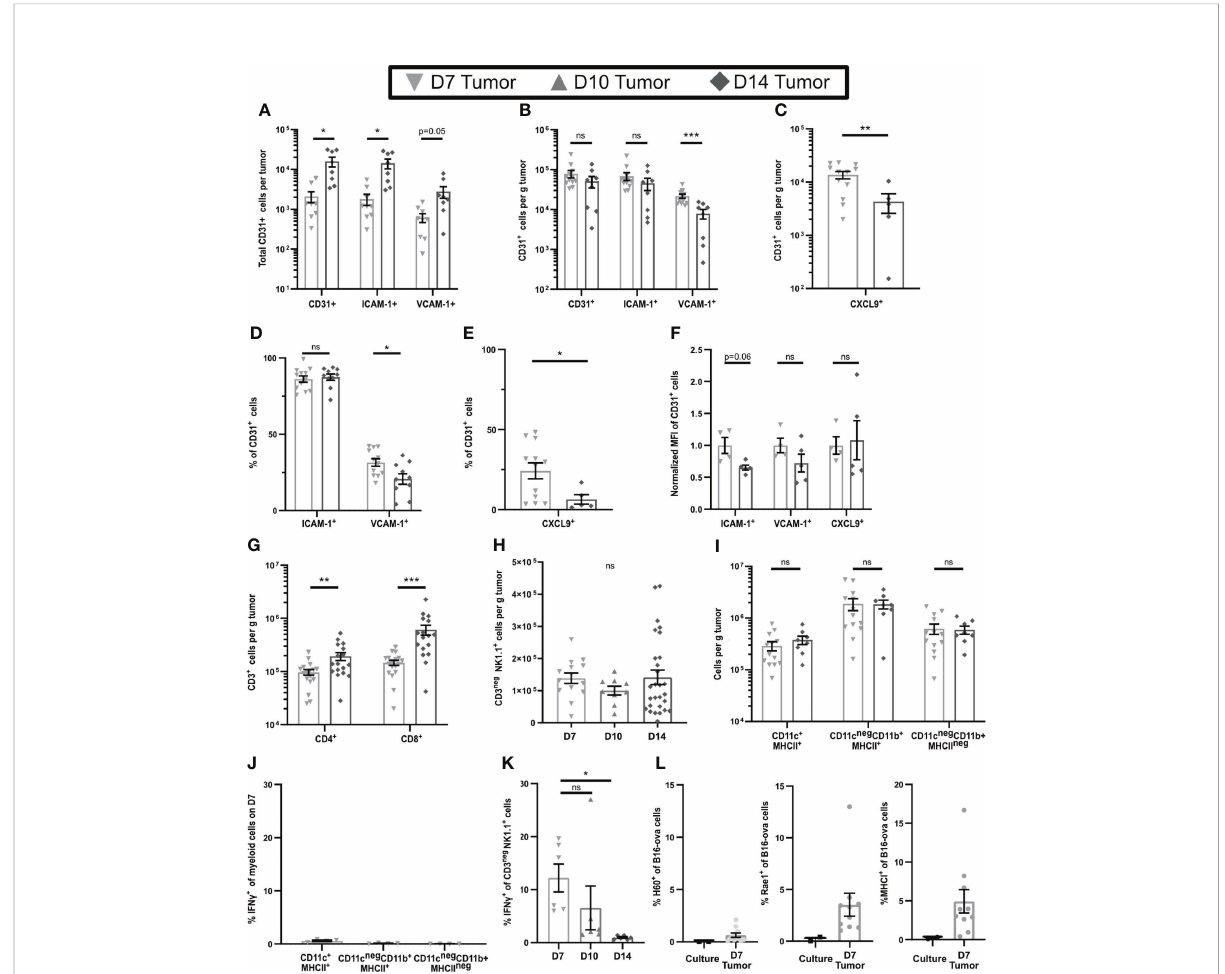
FIGURE 1 Early-stage tumors have high levels of endothelial HRL expression, substantial innate immune cell in fi ltrates, and functional NK cells. B16-ova tumors (A – K) , or B16-ova expressing IRFP720 to identify tumor cells (L) , were implanted into WT B6 mice and harvested on D7, D10, or D14. Single cell suspensions were enriched for CD45 + cells using MACS Beads and the CD45 neg (A – F, L) or CD45 + (G – K) fractions were analyzed by fl ow cytometry. (J, K) Mice were treated with BFA for cytokine analysis 4-6 hours prior to tumor harvest. (L) B16-ova cells expressing IRFP720 fl uorescent protein were analyzed by fl ow cytometry directly from culture prior to implantation and on D7. Data points represent a single tumor and mean per group with error bars representing SEM. Data are from: (A, B) 2 experiments; (C, E) 1-3 experiments; (D) 3 experiments; (F) 1 experiment; (G) 3-5 experiments; (H) 2-6 experiments; (I) 2-3 experiments; (J) 1 experiment; (K) 2 experiments; (L) 3 experiments. Statistics: (A – G, I) Unpaired Student ’ s T test with Welch ’ s correction; (H, J, K) One-way Anova with Tukey ’ s posttest. *p < 0.05; **p < 0.01; ***p < 0.001; ns, not signi fi